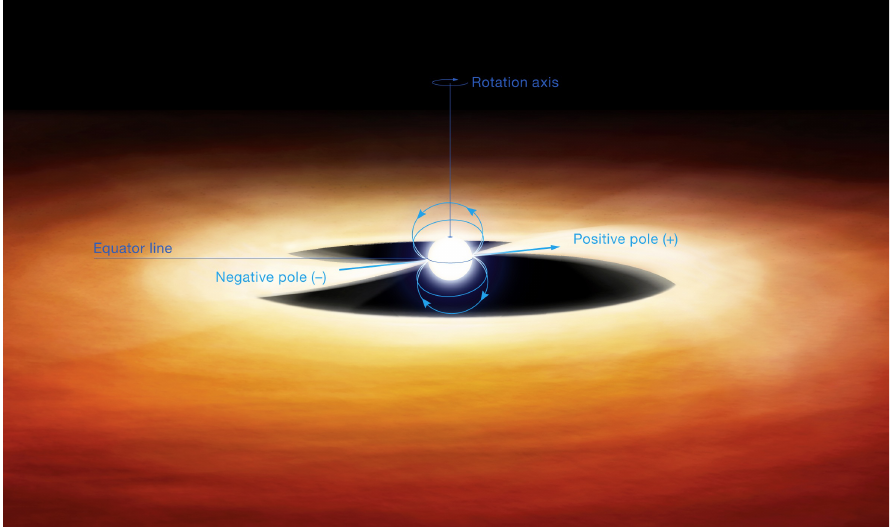
Figure 1. Artist’s impression of the MA in HD101412, looking at the magnetic equator. The exact size and shape of both the disk and the accretion streams are for illustration only, since we lack constraints on these parameters [18]. Credit: Schöller et al., A&A, 592, A50, 2016, reproduced with permission ©